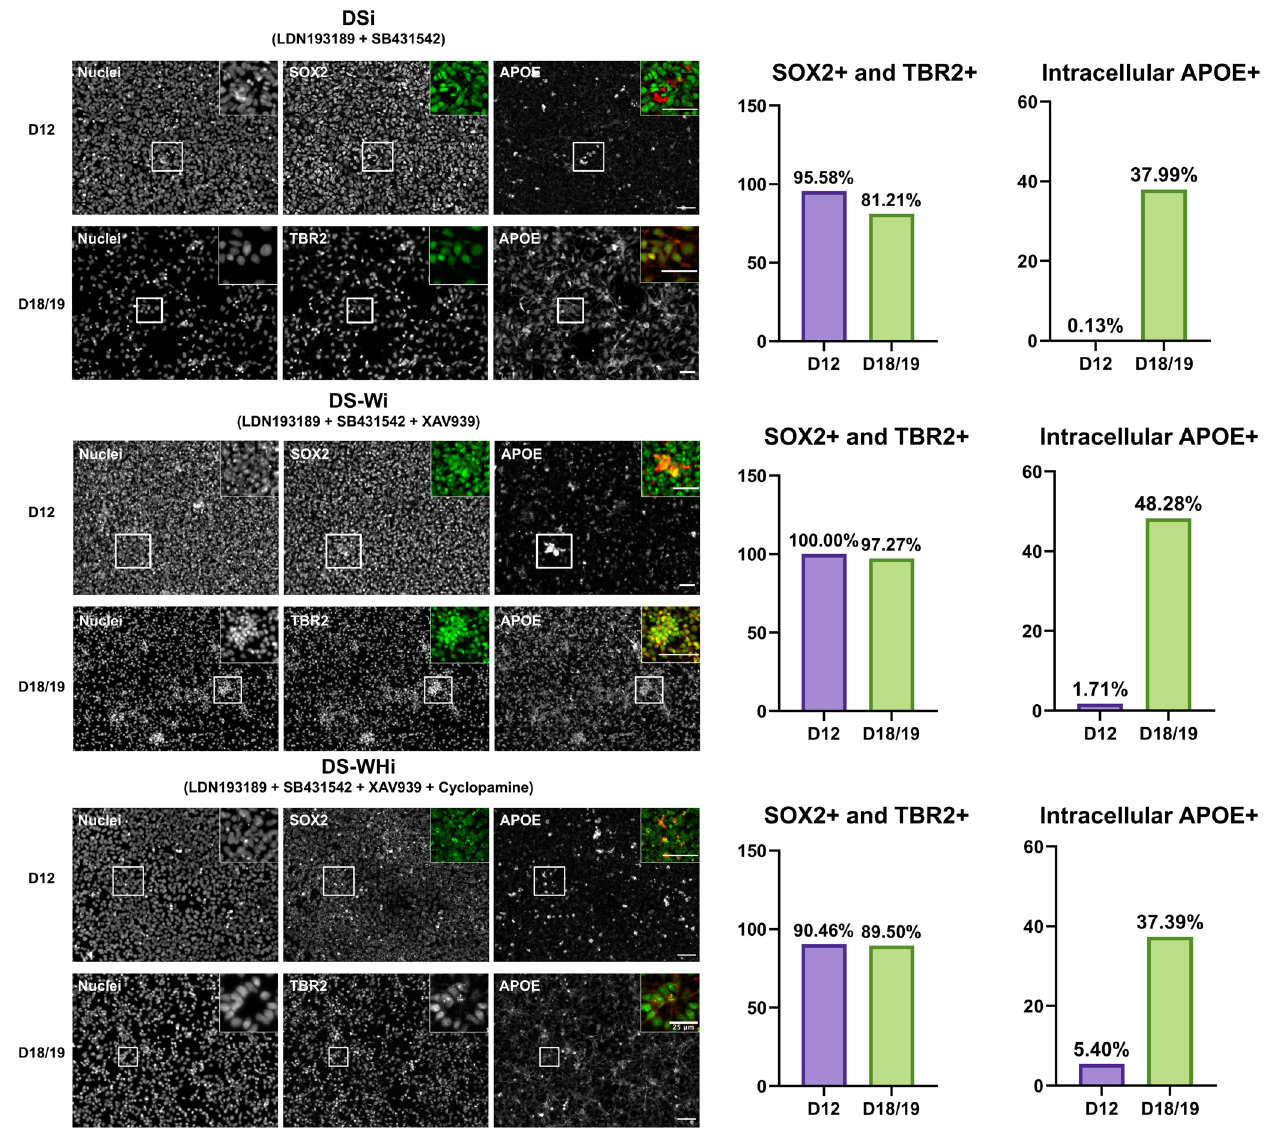
Figure 3. APOE localisation pattern becomes more intracellular with in vitro directed differentiation. APOE protein is more localised intracellularly in differentiated cells. (Left) Representative images of cells at D12 and D18/19 expressing SOX2 (NSC marker) and TBR2 (NPC marker), respectively. Insets show images of SOX2/TBR2 in green and APOE in red. Scale bars indicate 50 µm unless stated otherwise. (Right) Quantification of SOX2-/TBR2-positive cells and intracellular APOE-positive cells amongst SOX2-TBR2-positive cells.